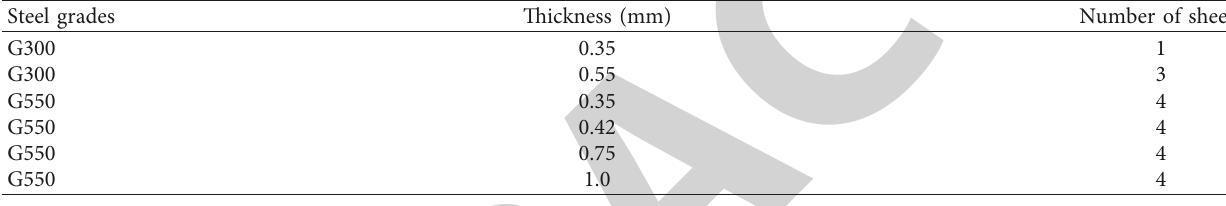
Figure 1: Experimental set up. Table 2: Steel samples used in this